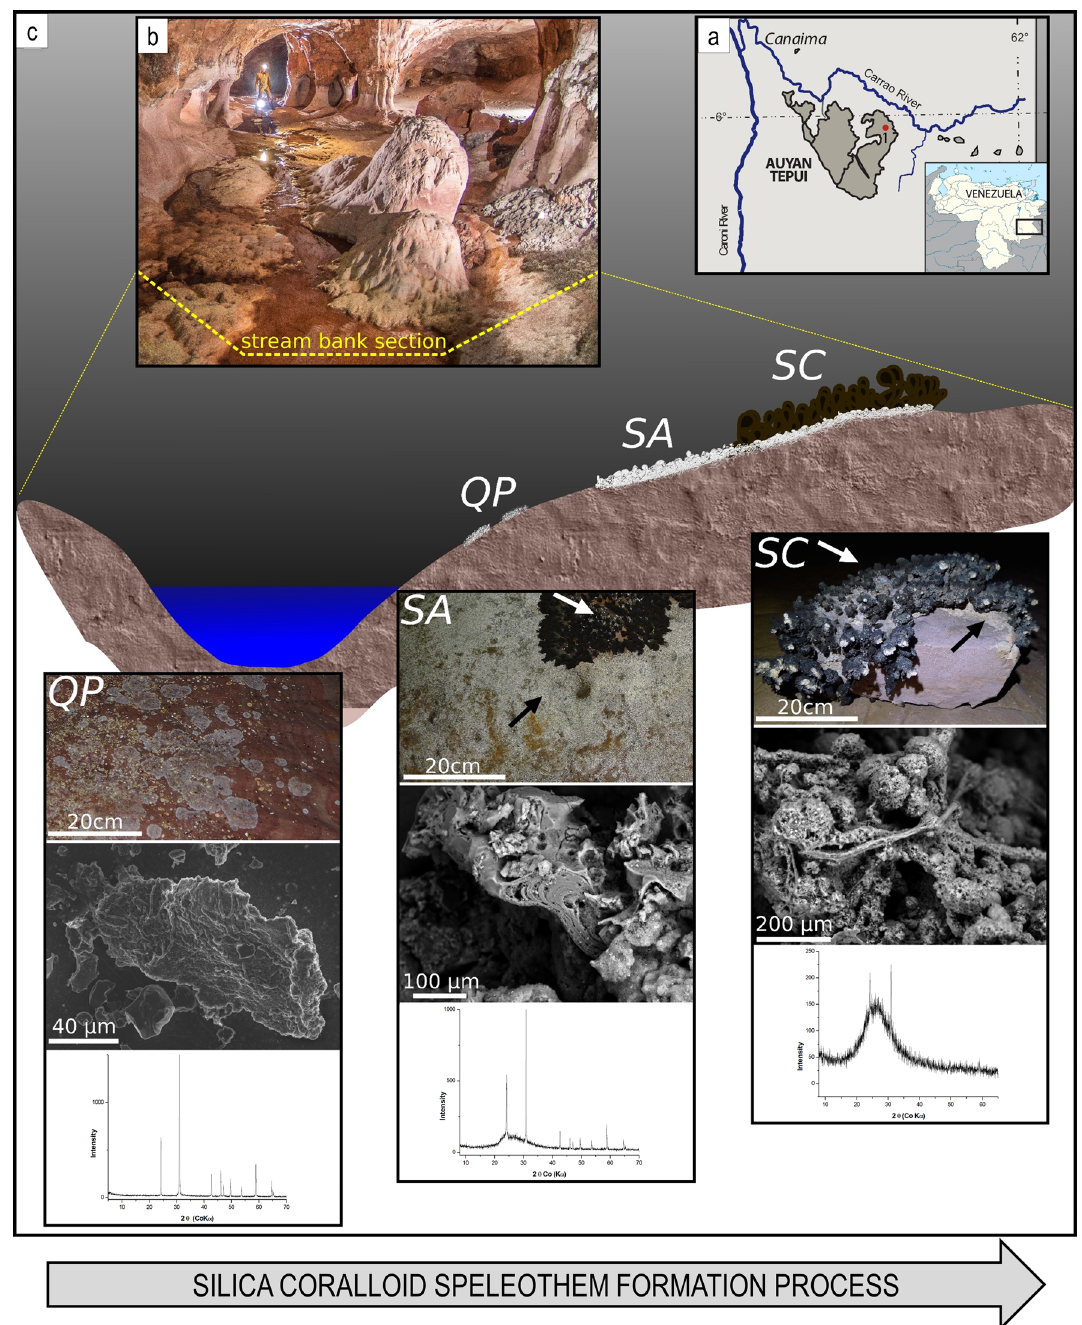
Figure 1. Study area, cave system and samples. ( a ) Geographical map indicating the location of Auyan Tepui table-mountain in Venezuela. ( b ) Picture of the cave location where the samples were collected along a stream bed with the indication of the stream bank section that is enlarged and schematized in panel C. ( c ) Schematic representation of the location and distance/height of samples QP, SA and SC from the stream bed. Black and white arrows point to SA and SC respectively. For each of the sample, the morphology, the FESEM image and the XRD pattern are shown. Photos are provided by La Venta